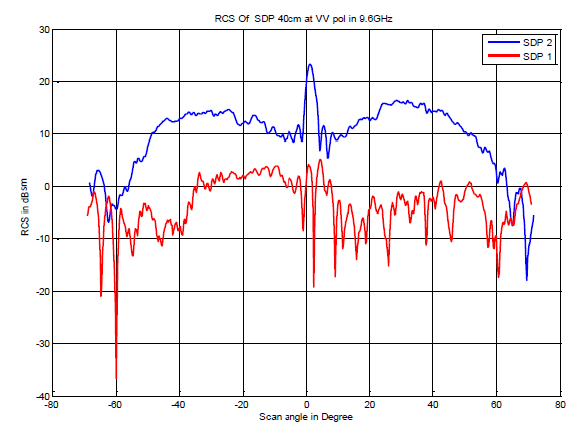
Figure 5(a): Plot of measured RCS values of SDP_40cm_HH,